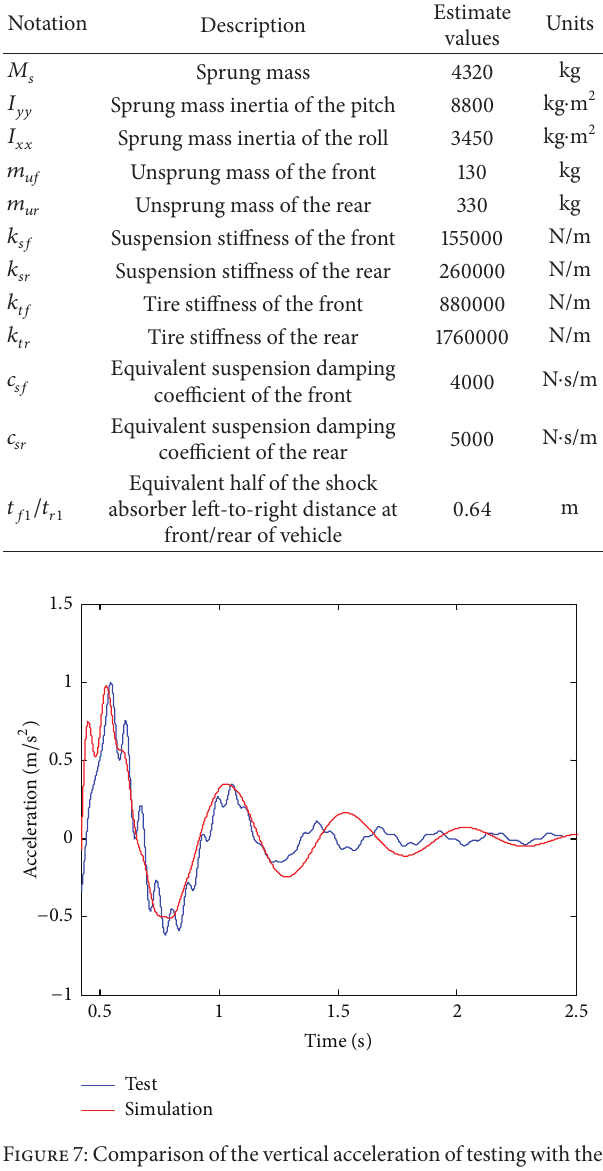
Table 4: The known physical parameters of the school bus.